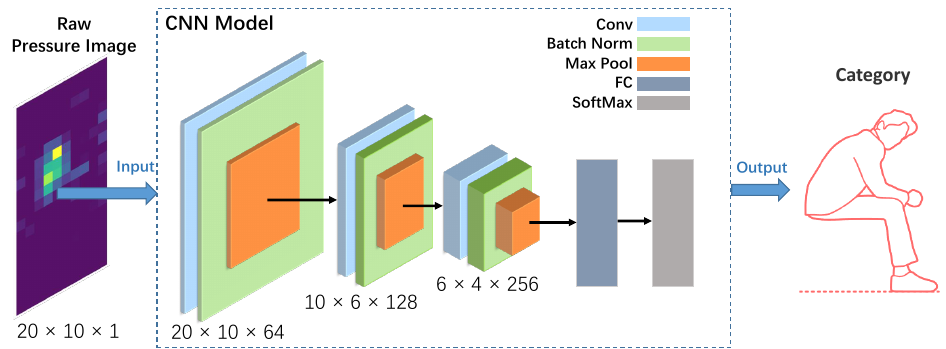
Figure 7. The CNN model. A network consisting of three main blocks is designed to convert the pressure image into a feature space, which is then fed to one dense layer leading to a logistic regressor for recognition of